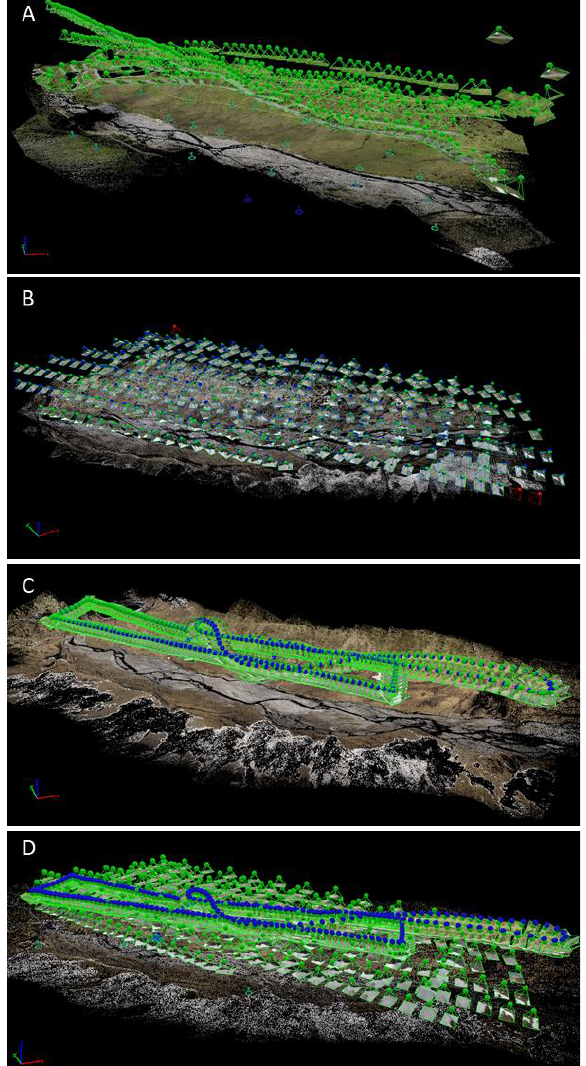
Figure 8. Image blocks after image orientation for: 2015 fixed- wing flight (A); 2019 Phantom4 imagery (B); 2019 RiCOPTER imagery (C); 2019 combined image block (D).